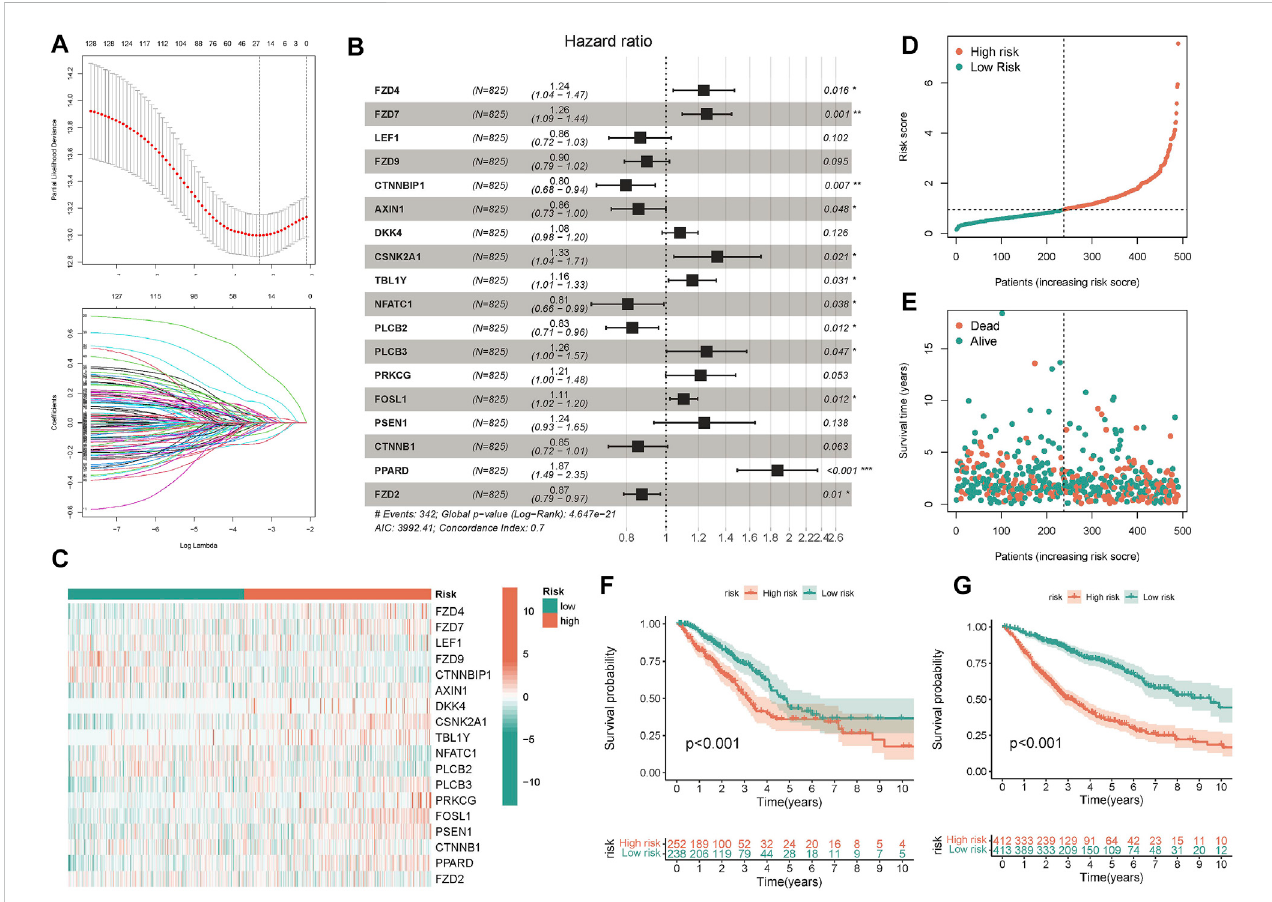
FIGURE 5 Construction and validation of predictive model. (A) 26 candidate genes were selected by LASSO regression (B) The forest map displayed the hazard ratiosofthe18targetgenes (C) Theheatmapdisplayedtheexpressionvaluesof18targetgenesindifferentriskscoregroups. (D,E) Thescatterplotdepictsthe distribution of patient risk values and mortality. (F,G) The K-M survival model was constructed to explore the predictive